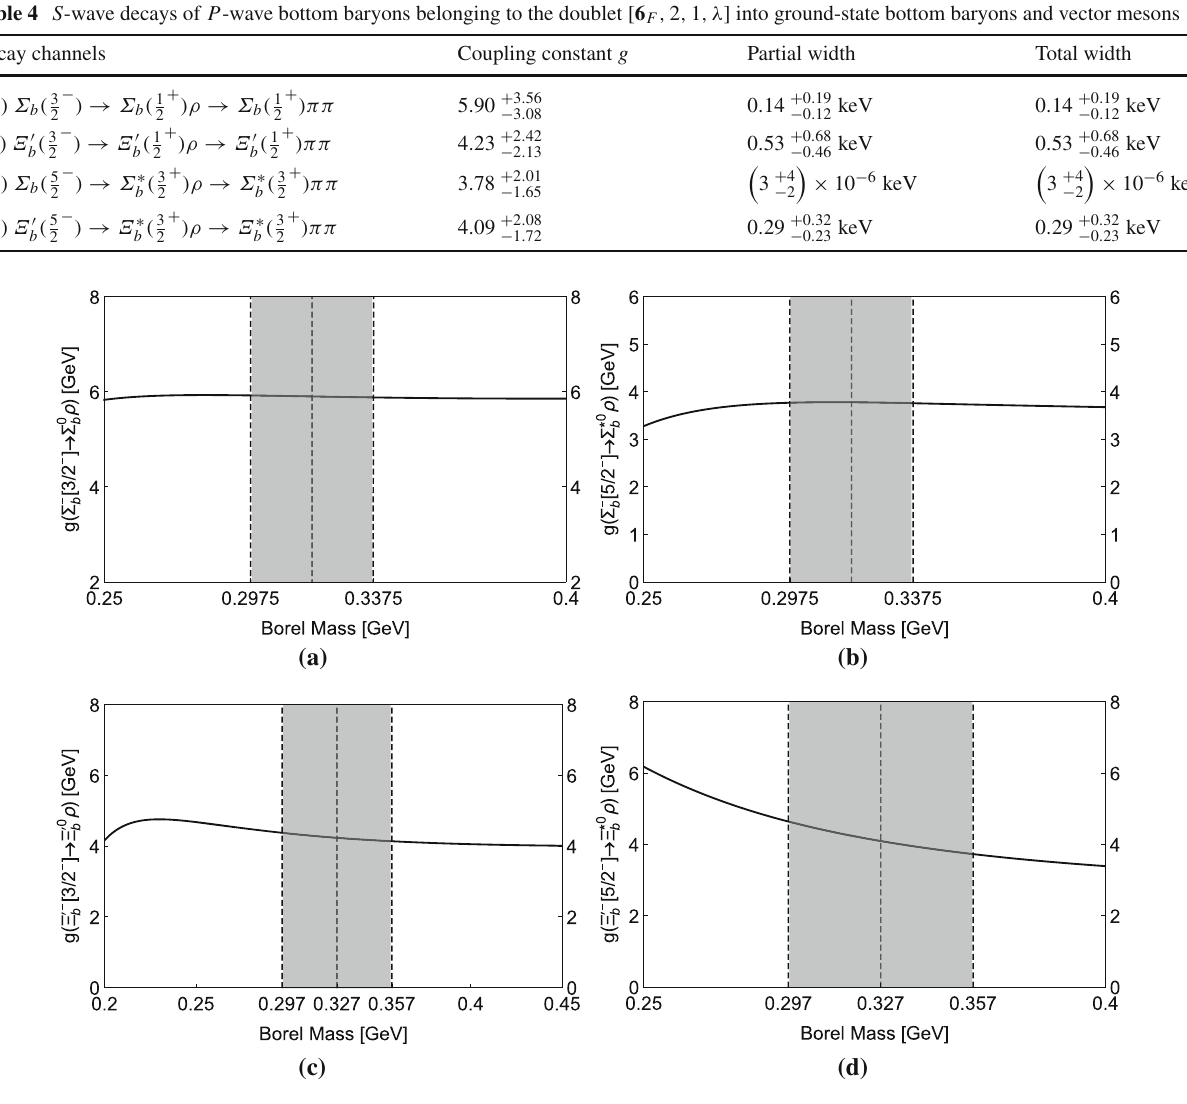
Fig. 5 The coupling constants a g c g , and d g − ]→ Ξ (cid:4) 0 Ξ (cid:4)− [ 3 ρ − b b 2 mass T . Here the baryons Σ b ( 3